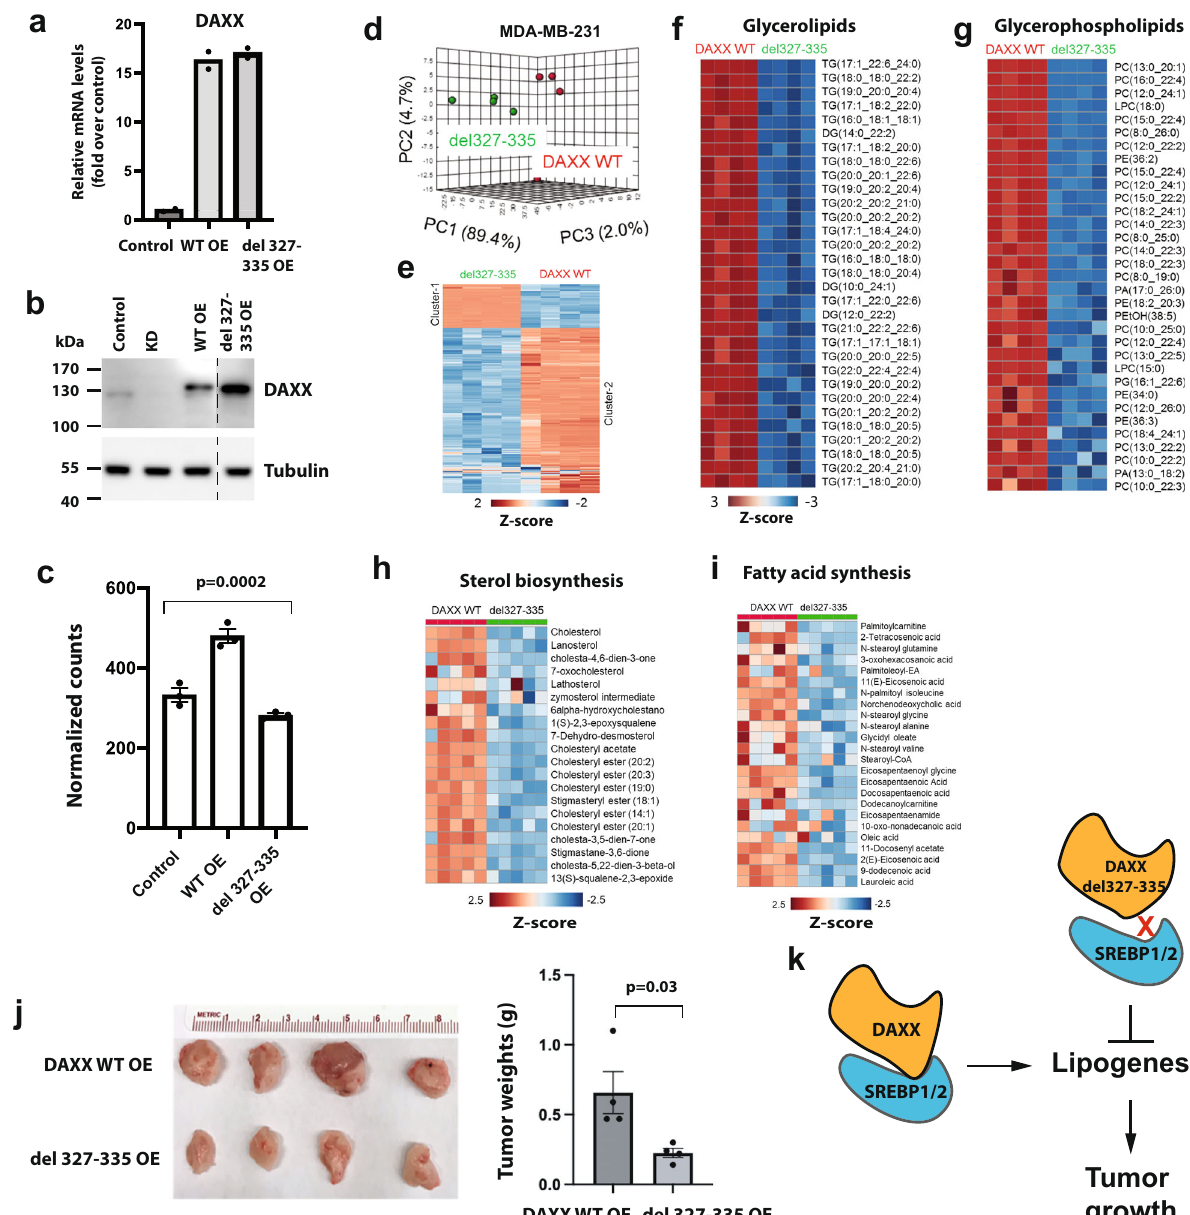
Fig. 7 | The DAXX – SREBP interaction is critical for lipid synthesis and tumor growth.a RelativemRNAlevelsof DAXX inMDA-MB-231cellsexpressingtheWTor del 327 – 335 mutant cDNA of DAXX as determined by RT-qPCR ( n =2). b DAXX proteinlevels in controlcells and those withKD, WTand del327 – 335 mutantcDNA of DAXX . c The DAXX del 327 – 337 mutant impaired de novo lipogenesis. Serum- starved cells were labeled with [1- 14 C] acetate and total lipids were isolated. Radioactivity was counted and normalized against total protein level. The P value was calculated using ordinary one-way ANOVA ( n =3 biologically independent samples). d PCA of lipidomes in MDA-MB-231 cells expressing the del 327 – 335 mutant and WT DAXX . Each dot represents a sample ( n =4). e Hierarchical clus- tering heatmap analysis of global lipidomes in cells expressing the del 327 – 335